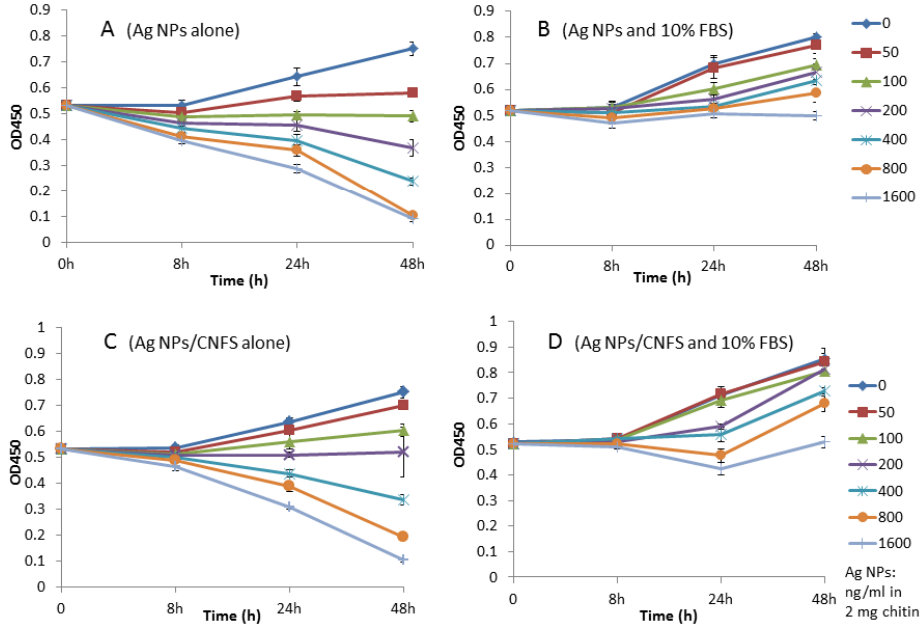
Figure 1. Fibroblast cell proliferation assay. Human fibroblasts were cultured with ( B , D ) or without ( A , C ) 10% fetal bovine serum (FBS) and various concentrations of silver nanoparticles (Ag NPs) alone or Ag NPs/chitin complex (Ag NPs/CNFS) for 2 days. Data represent the mean ± SD of 6